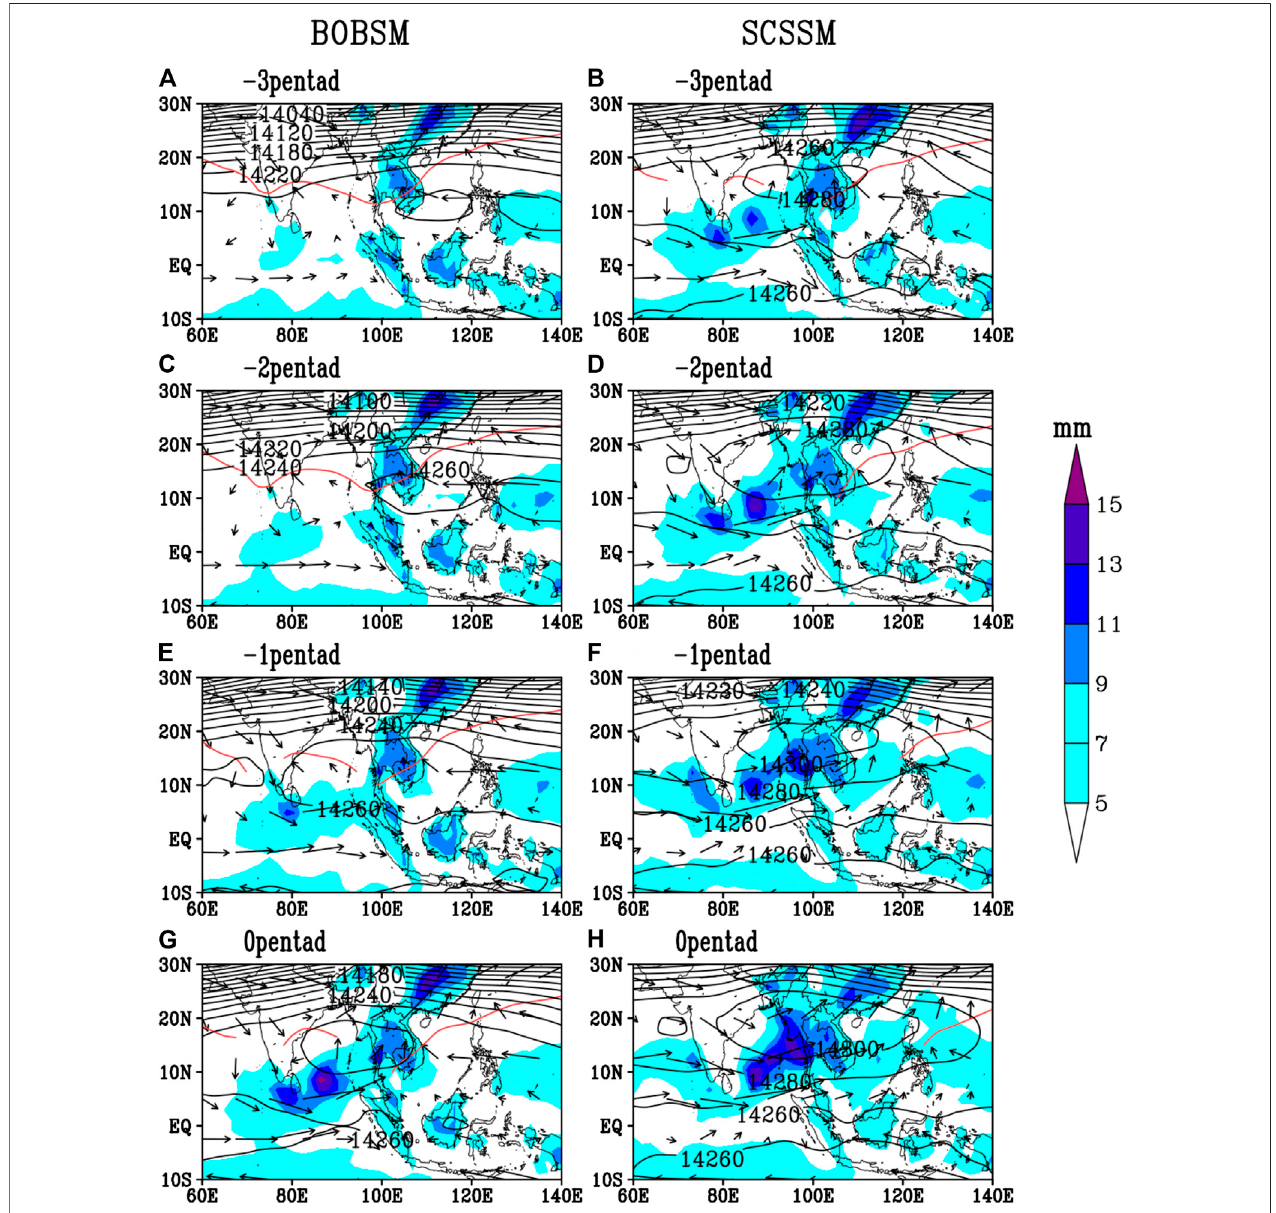
FIGURE3| Compositemapsofprecipitation(shaded;unit:mm),850 hPahorizontalwind(vectors;unit:m/s),andgeopotentialheightat150 hPa(contour;unit:m) from − 3 pentad to the onset pentad of (left panel) BOBSM and (right panel) SCSSM in the period of 1958 – 1979. The red line represents the ridge of western North subtropical high, which is de fi ned by the zero zonal wind at 850 hPa (u (cid:2) 0 m/s).